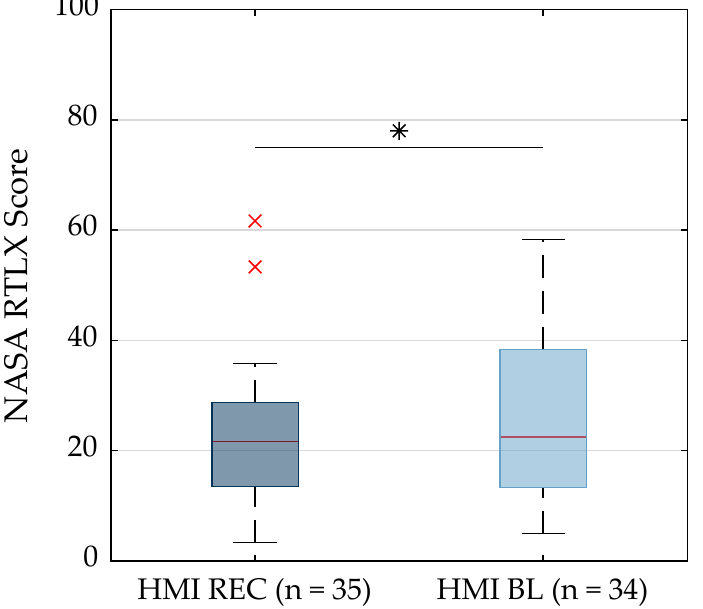
Figure 10. NASA RTLX scores. Outliers are marked as red crosses. The asterisk represents a statistical significant difference ( p <